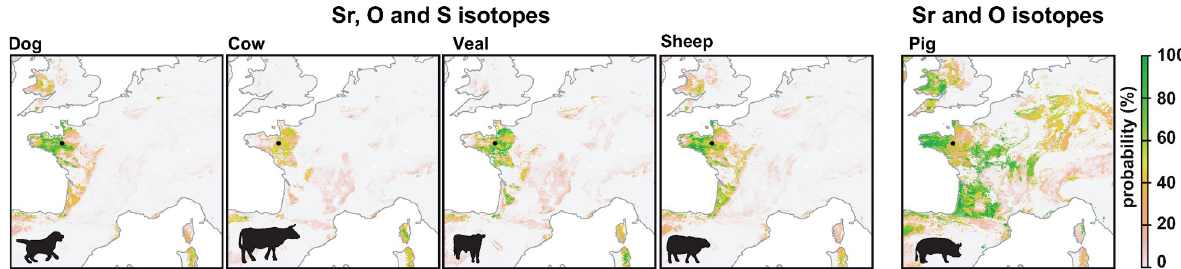
Fig 4. Maps showing the probability of geographic origins of the animals based on strontium, sulfur and oxygen isotope data in teeth. For the sheep, strontium and oxygen isotope values represent an average of two teeth M1 and M3. Sulfur isotopes were not analysed for the pig individual due to budget constraints. To generate these figures the script is available in S1 and S2 Scripts.